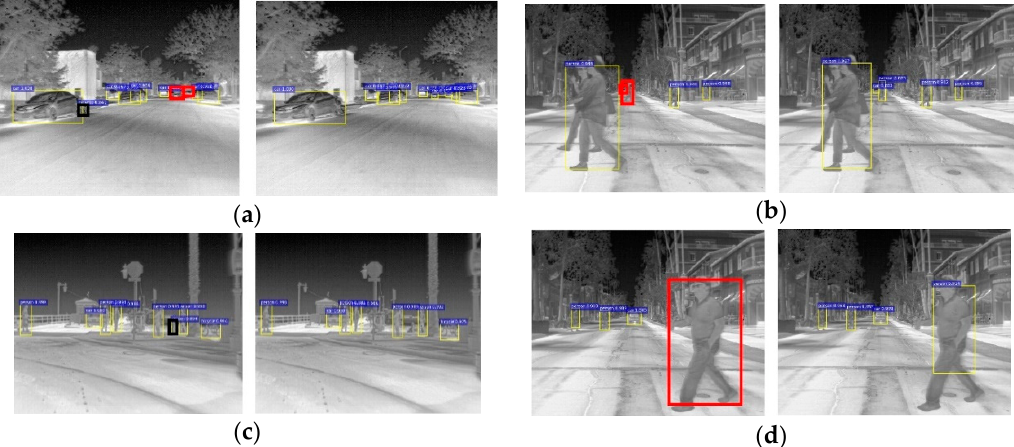
Figure 5. Comparative results ( a ) between Ours6 and Ours4, ( b ) between Ours5 and Ours4, ( c ) between Ours3 and Ours4, ( d ) between Ours7 and Ours4. Yellow lines indicate correctly ‐ detected objects, red lines indicate misjudged objects, and black lines indicate incorrectly ‐ detected objects.